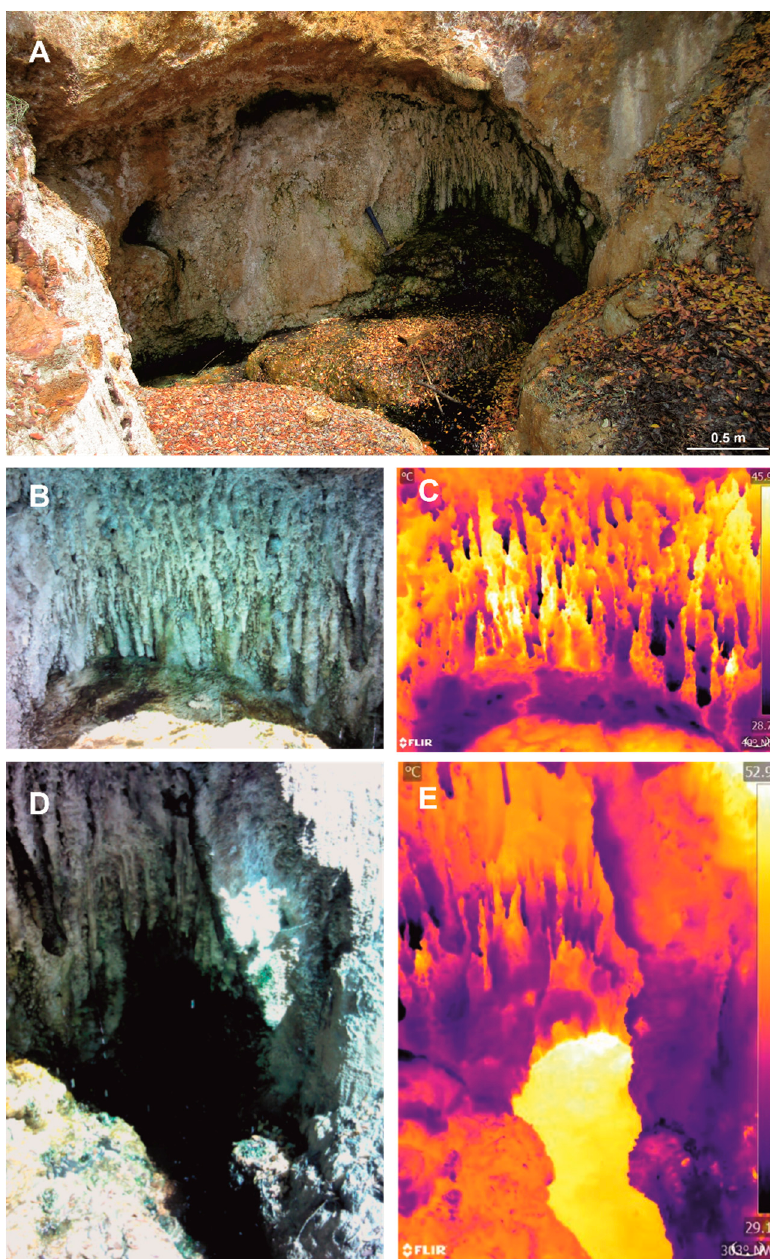
Figure 2. ( A ) Overview of the study site. ( B – E ) Paired views of normal images ( B , D ) and corresponding thermal images ( C , E ). A column shows the temperature scale (°C) on the right side of the thermal pictures. ( B , C ) Photo of the stalactites where the samples were collected. ( D , E ) Overview of the hot spring at the bottom of the cave and some stalactites at the top.